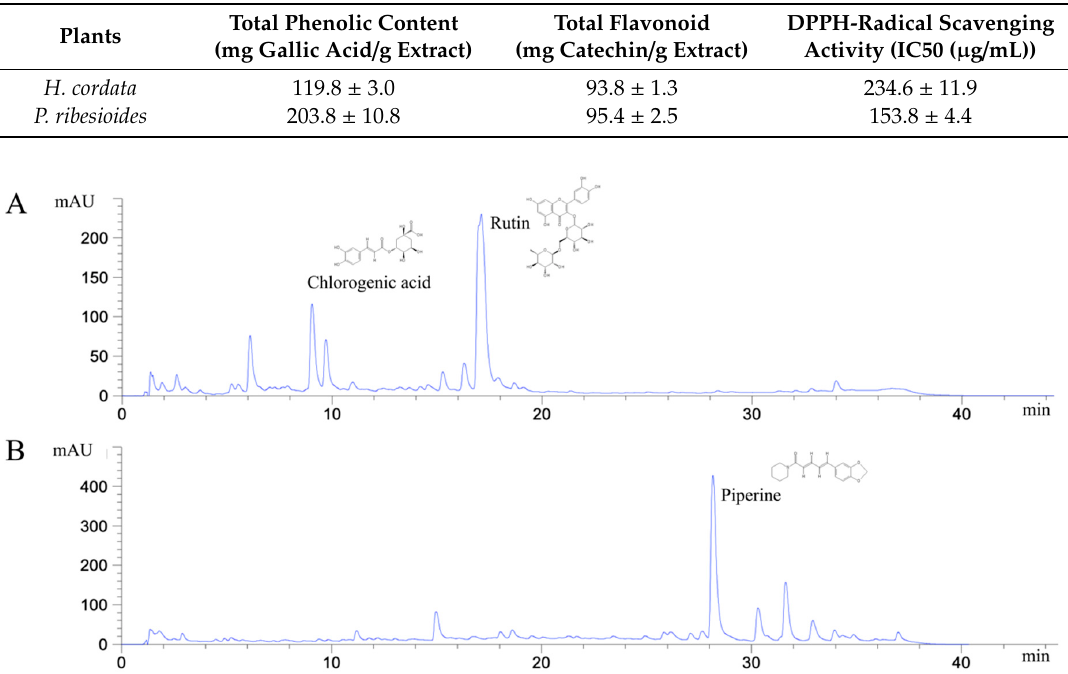
Table 1. Determination of total phenolic and flavonoid contents and DPPH radical scavenging capacity of H. cordata and P. ribesioides extracts. Results are presented as mean ± SD from three independent experiments.